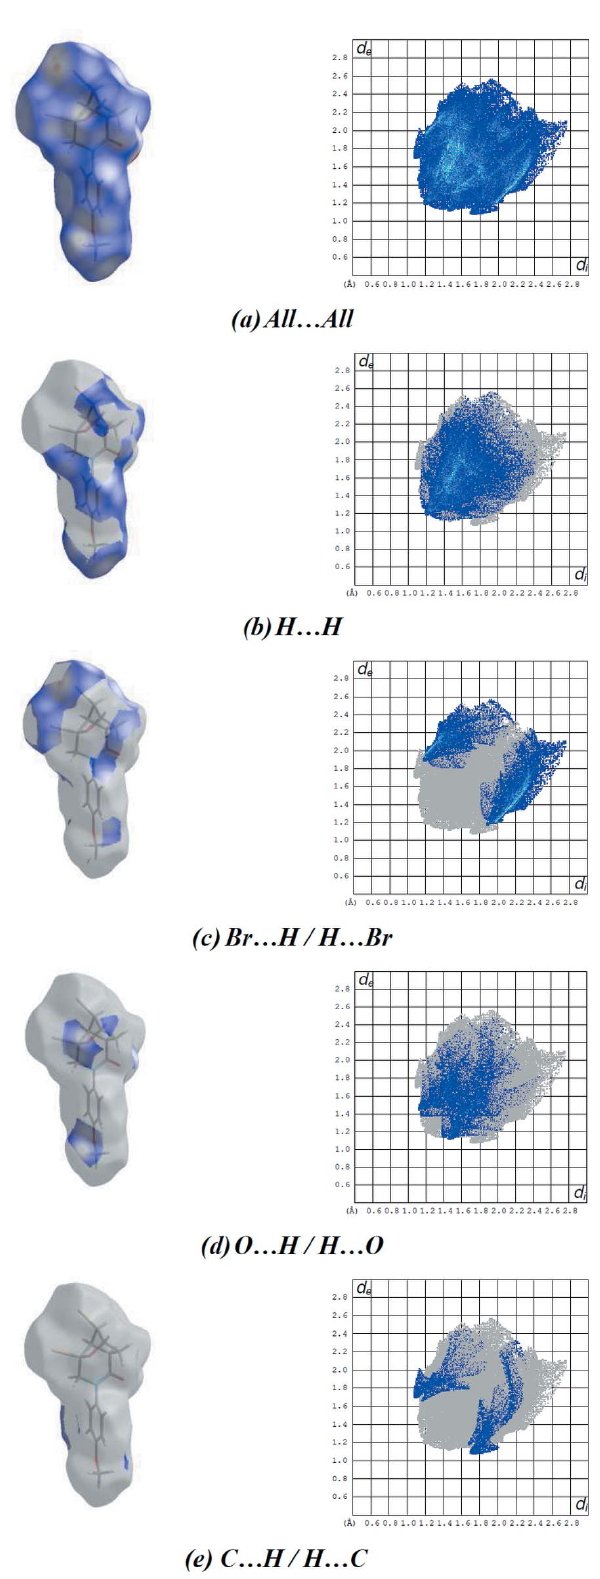
Figure 6 A view of the three-dimensional Hirshfeld surfaces and the two- dimensional fingerprint plots for 2 , showing ( a ) all interactions and delineated into ( b ) H (cid:2)(cid:2)(cid:2) H, ( c ) Br (cid:2)(cid:2)(cid:2) H/H (cid:2)(cid:2)(cid:2) Br, ( d ) O (cid:2)(cid:2)(cid:2) H/H (cid:2)(cid:2)(cid:2) O and ( e ) C (cid:2)(cid:2)(cid:2) H/H (cid:2)(cid:2)(cid:2) C interactions. The d i and d e values are the closest internal and external distances (A˚ ) from given points on the Hirshfeld